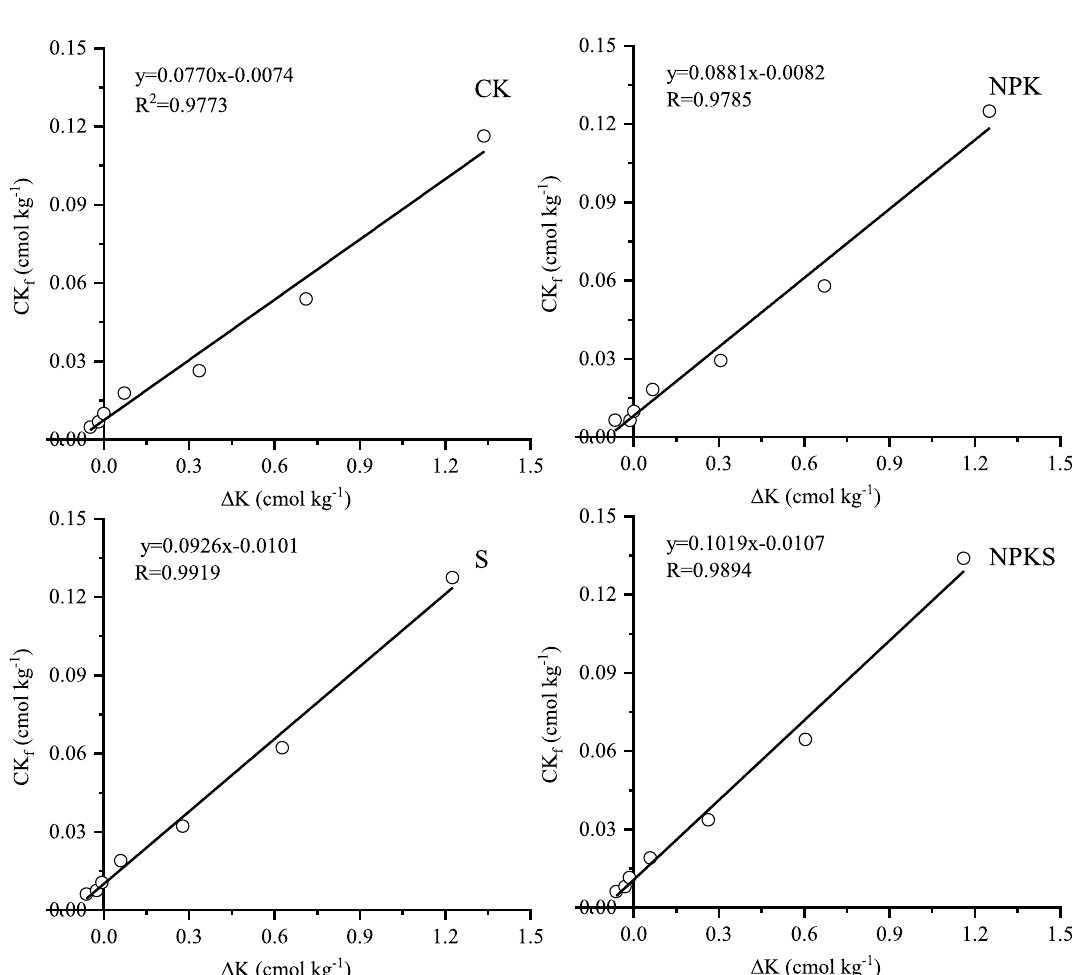
Figure 5. Plots of CK f versus ΔK for tested soils with and without straw return. (CK, no fertilization; NPK, mineral fertilizing; S, straw 6000 kg h m −2 ; NPKS, NPK with straw 6000 kg h m −2 ; CK f , Potassium concentration in soil solution after equilibration period; ΔK, amount of total K adsorbed or release from soil during